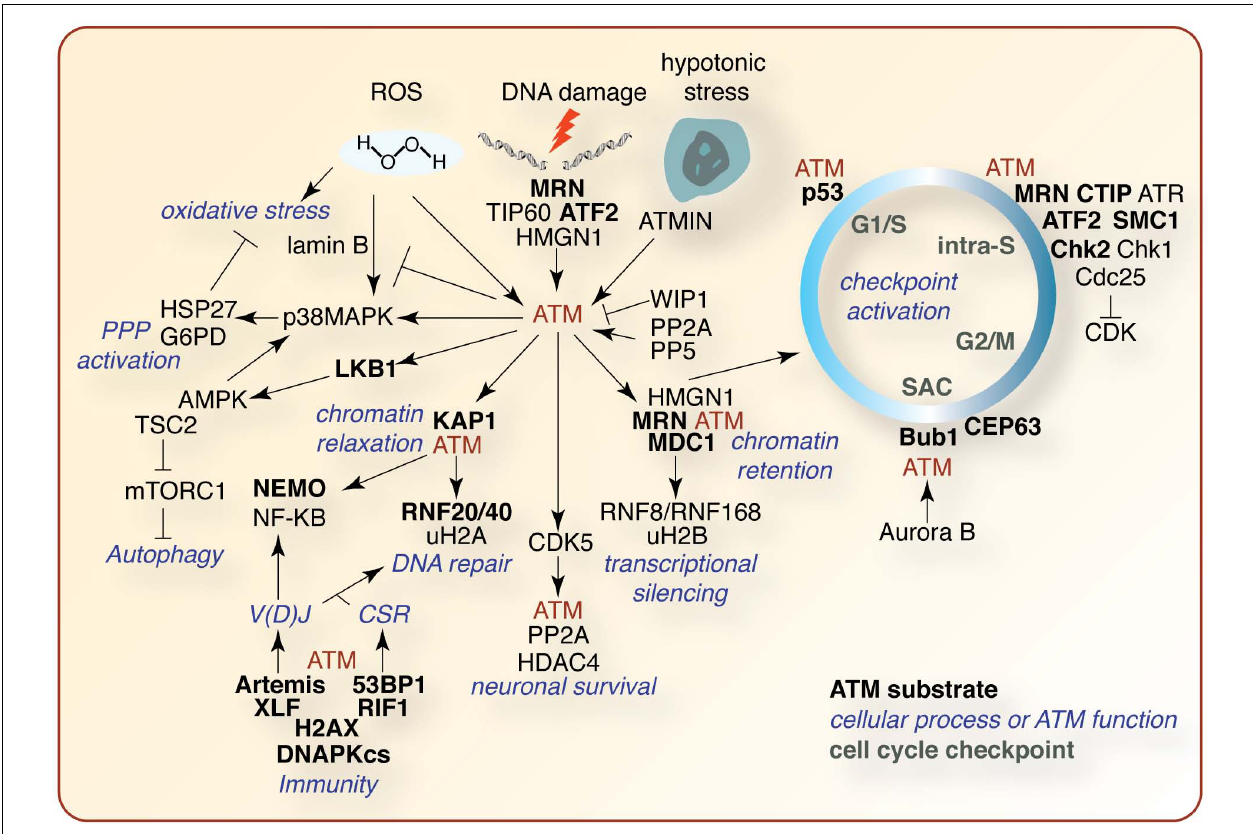
FIGURE 4 | Selected summary of theATM signaling network. A non-comprehensive schematic of ATM signaling pathways described in the text. ATM substrates are indicated in bold black, other pathway effectors in black, affected cellular processes in blue, and cell cycle checkpoints in green. See text for details regarding the signaling pathways